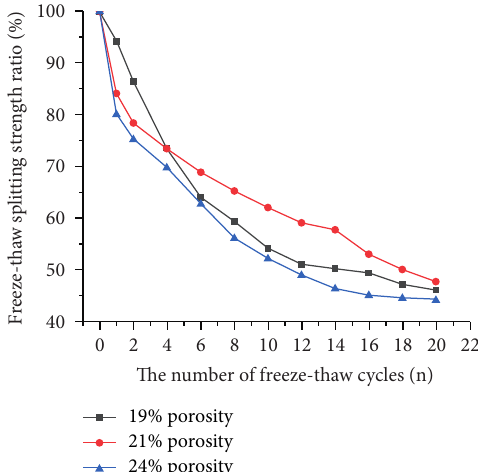
Figure 4: Variation diagram of the specimens’ tensile strength ratio for different porosities.